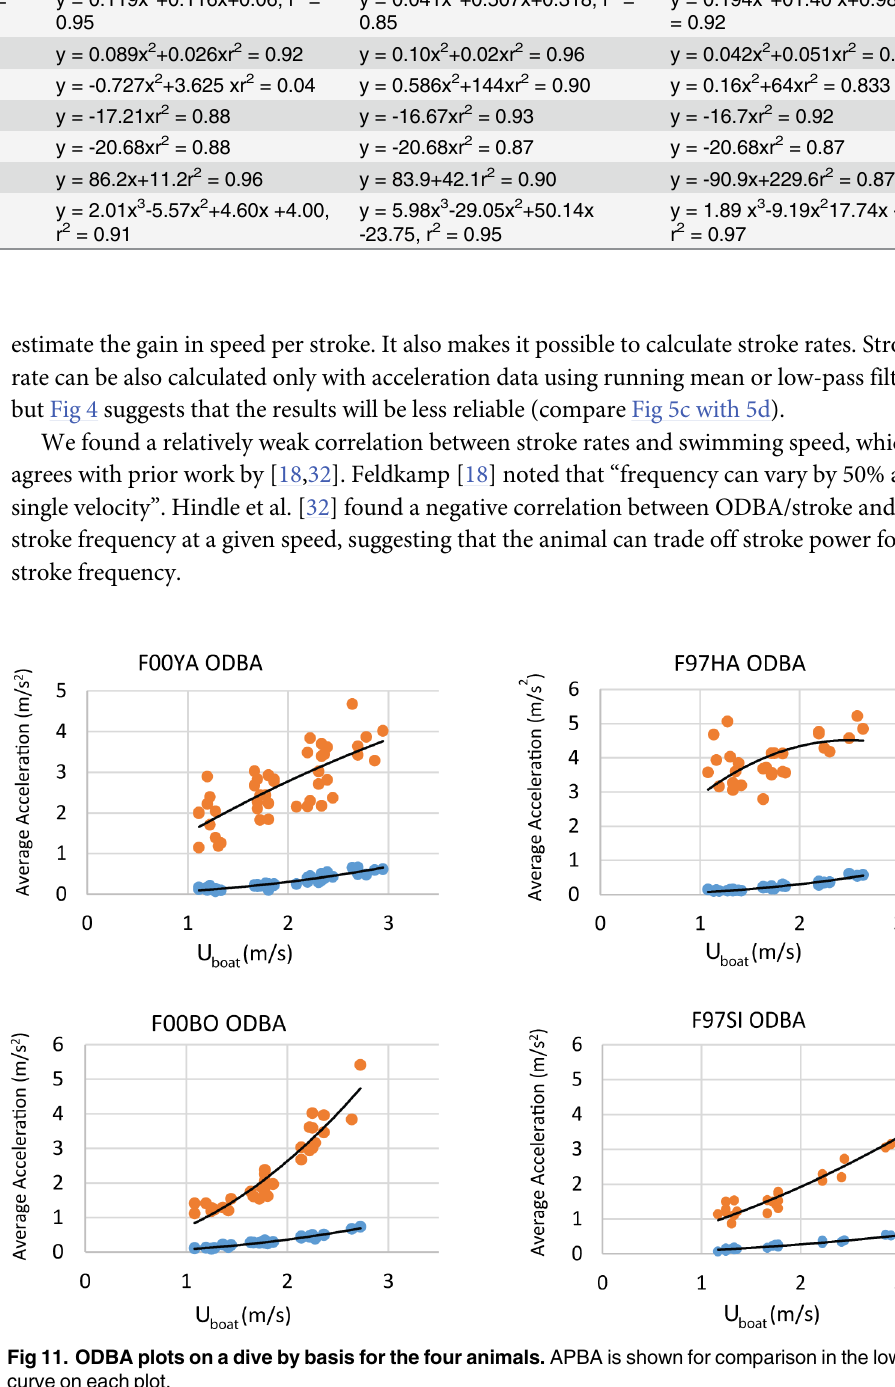
Fig 11. ODBA plots on a dive by basis for the four animals. APBA is shown for comparison in the lower curve on each plot.